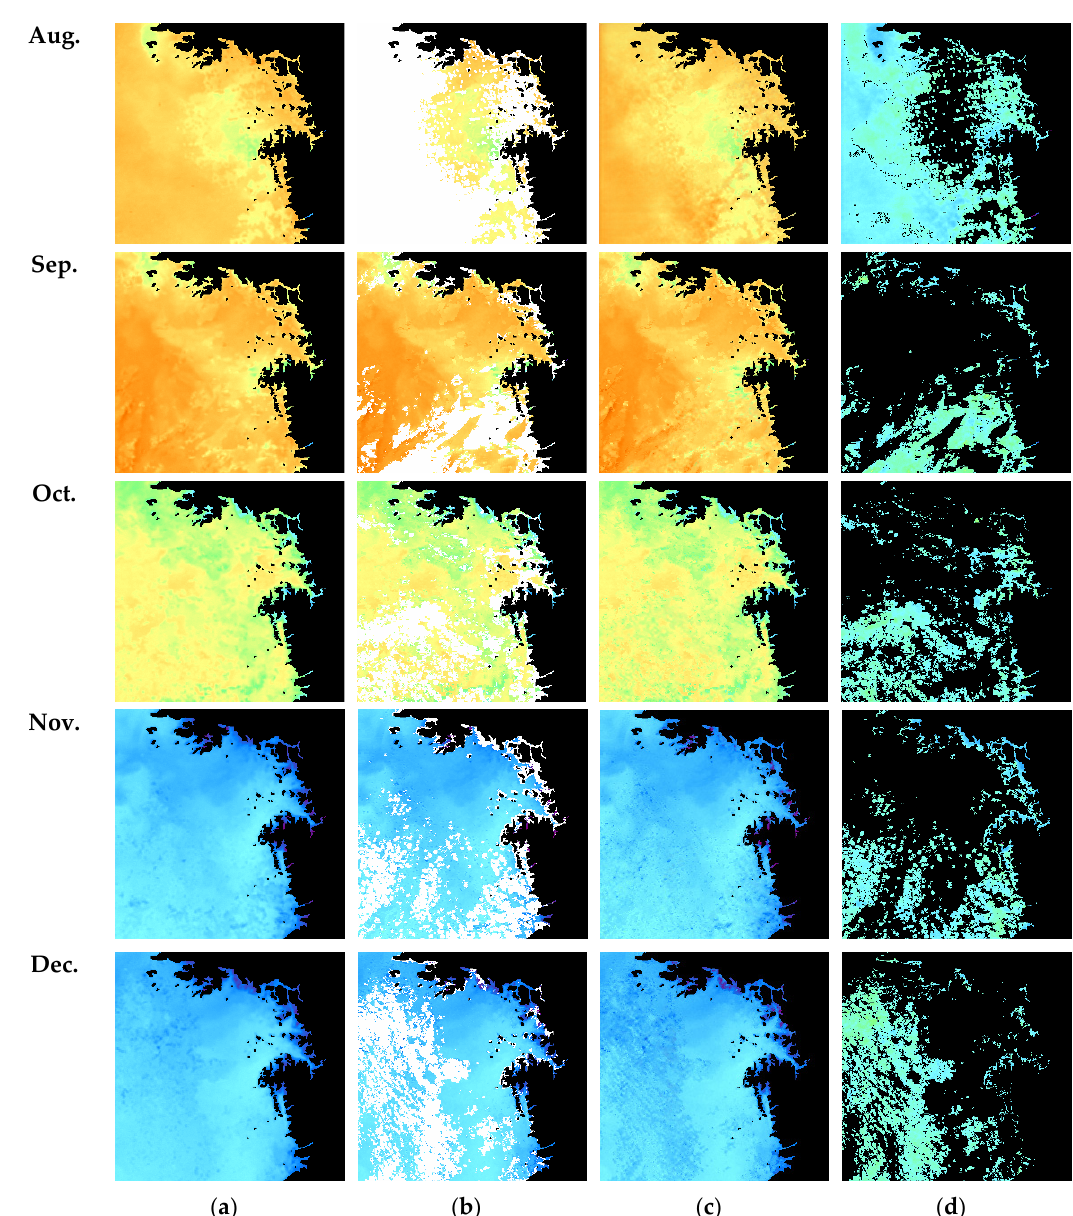
Figure 7. Visualized examples to demonstrate the restoration capability of the proposed GIN model. ( a ) DayMOM (ground-truth) images, ( b ) DaySST (test) images with missing (occluded) regions, ( c ) restored images created using our GIN model, ( d ) difference map images representing difference in pixel values computed between the DayMOM and restored images. White pixels indicate the occluded region by clouds and black pixels indicate land.